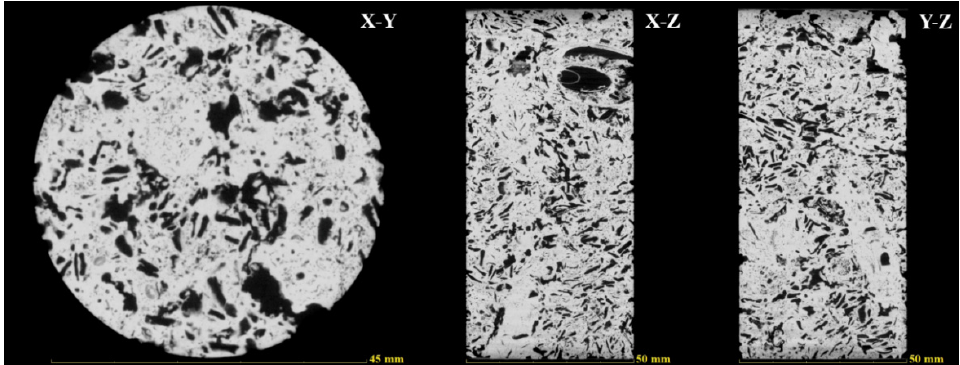
Figure 6. Cross sectional images of sample A when scanning along Z, Y, X axes.